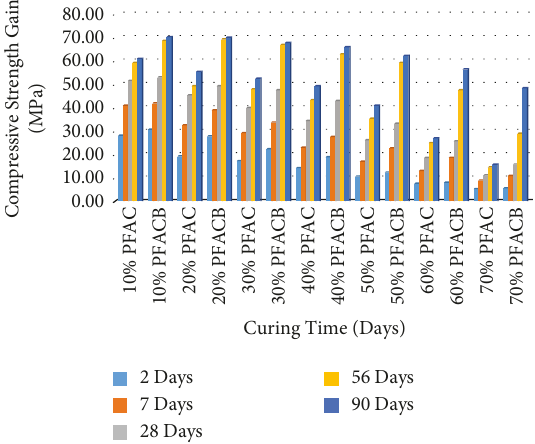
Figure 5: Compressive strength of OPC blended with PFA (w/c (cid:30)